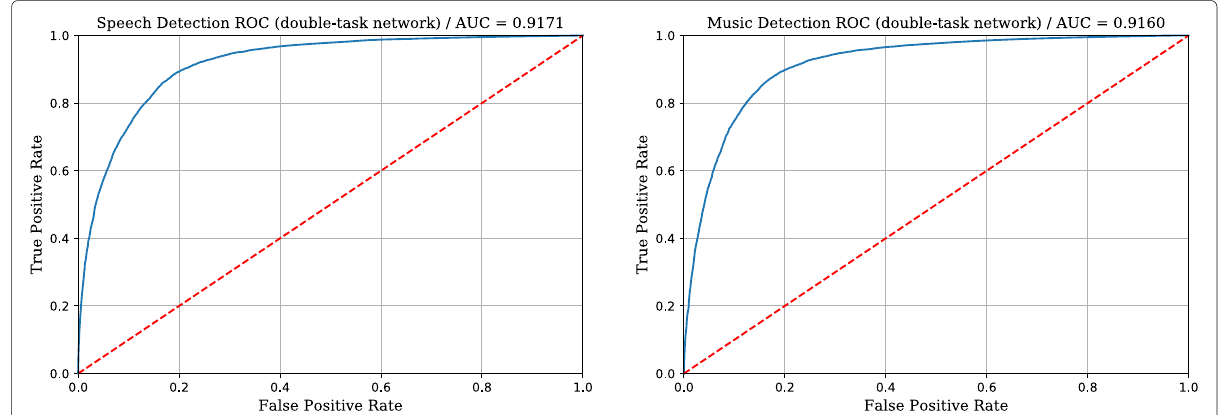
Fig. 11 ROC curves (solid blue lines) of the best obtained system for speech and music event detection. The AUC (area under curve) is 0.9171 for speech event detection and 0.9160 for music event detection